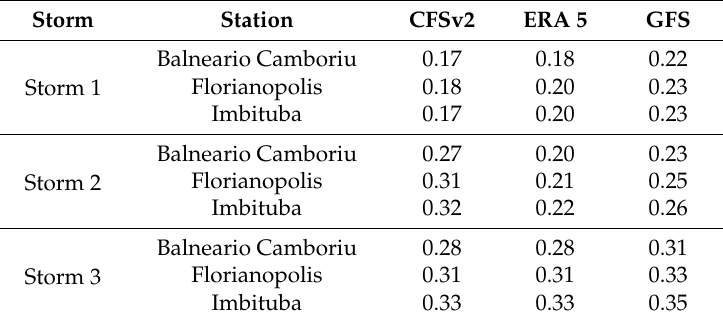
Table 2. Surge-only error metrics (RMSE in